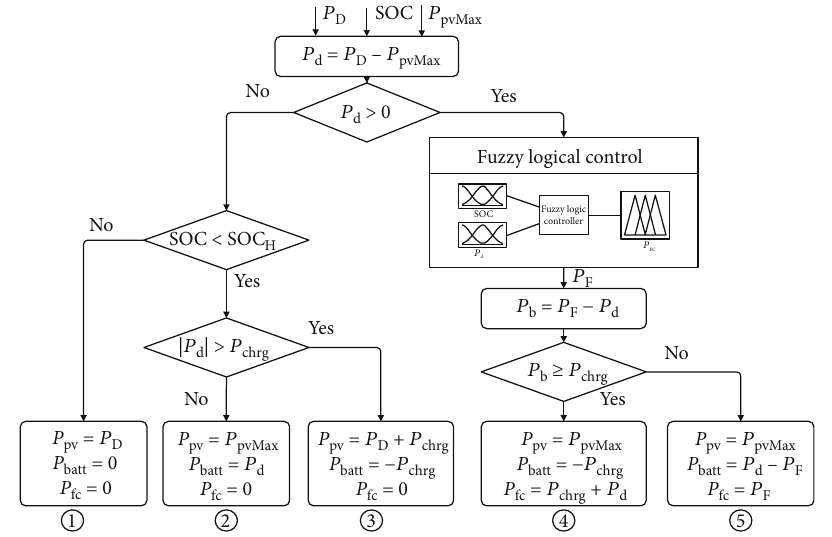
Figure 2: Fuzzy state machine energy management